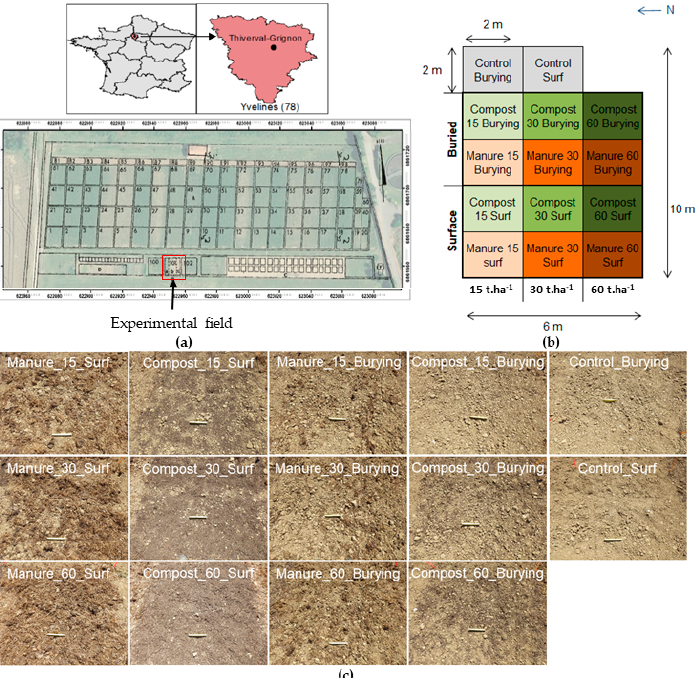
Figure 2. Map of the experimental device Dehérain (Author Jean Marc Gilliot) in Thiverval-Grignon,